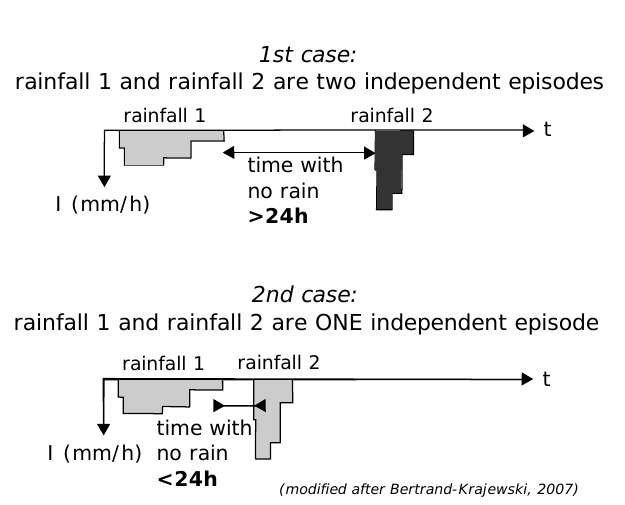
Figure 3. Schematic representation of the definition of an indepen- dent rainfall